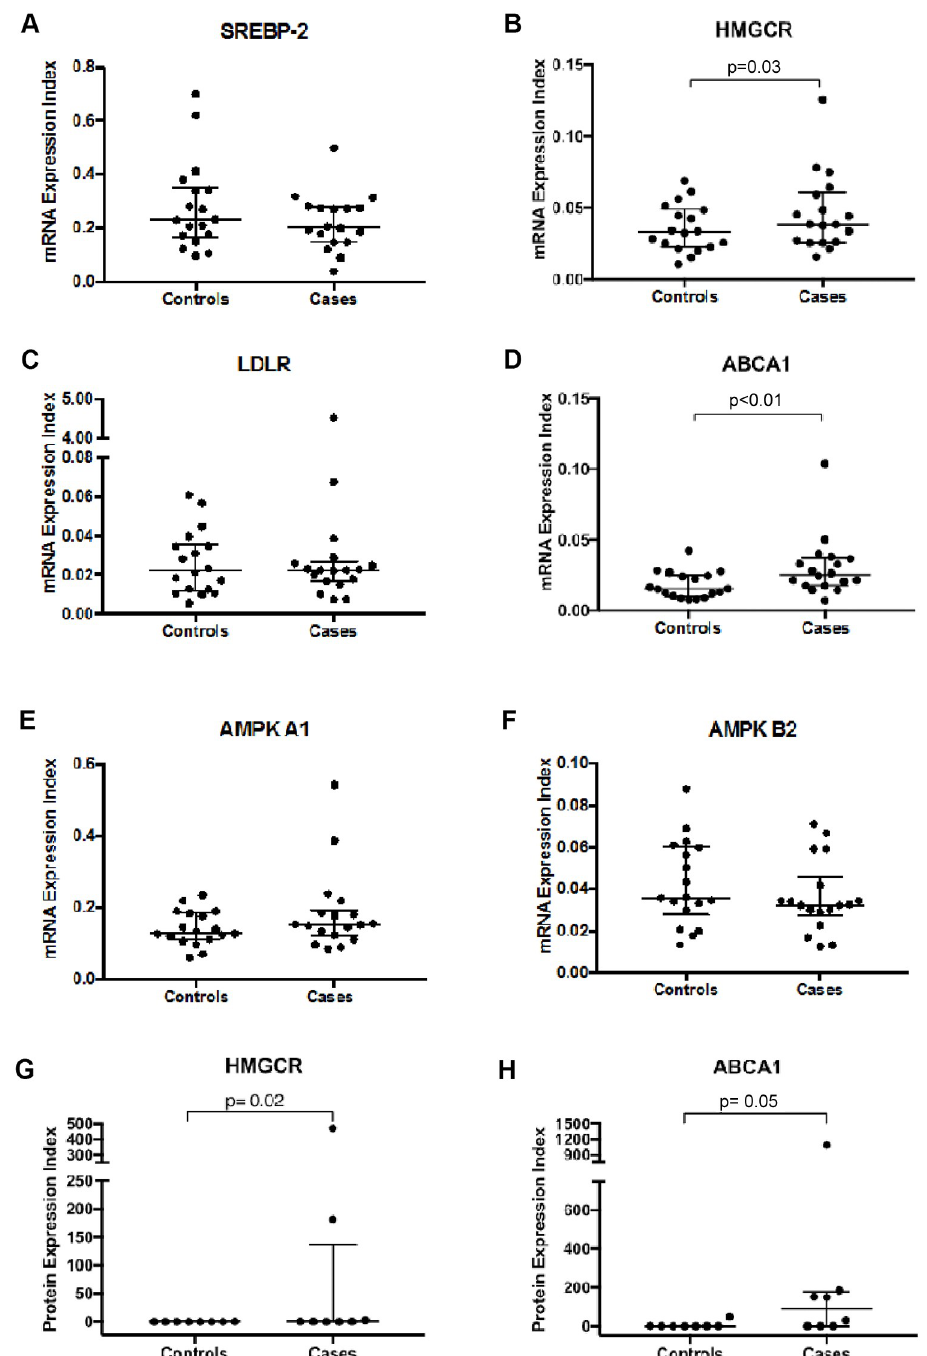
Fig 1. mRNA and protein expression of cholesterol biosynthesis genes in peripheral blood mononuclear cells (PBMCs) of participants. HIV positive individuals on ART (cases, n = 18) and HIV negative individuals (controls, n = 18). A. mRNA expression of Sterol response element binding protein 2 (SREBP-2). B. mRNA expression of HMG coenzyme reductase A (HMGCR). C. mRNA expression of Low-density lipoprotein receptor (LDLR). D. mRNA expression of Adenosine triphosphate–binding cassette transporter A1 (ABCA1). E. mRNA expression of AMP Kinase A1 (AMPK A1). F. mRNA expression of AMP Kinase A2 (AMPK A2). Protein expression of cholesterol biosynthesis genes in PBMCs of HIV positive individuals on ART (cases: N = 8) and HIV negative individuals (controls: N = 8). The density of the bands was quantified using Quantity One Analysis Software. Data are median (25 th – 75 th percentiles of interquartile range), p values represent Wilcoxon matched-pairs signed-rank test, with significance being p < 0.05. G. protein expression of HMGCR. H. protein expression of ABCA1.